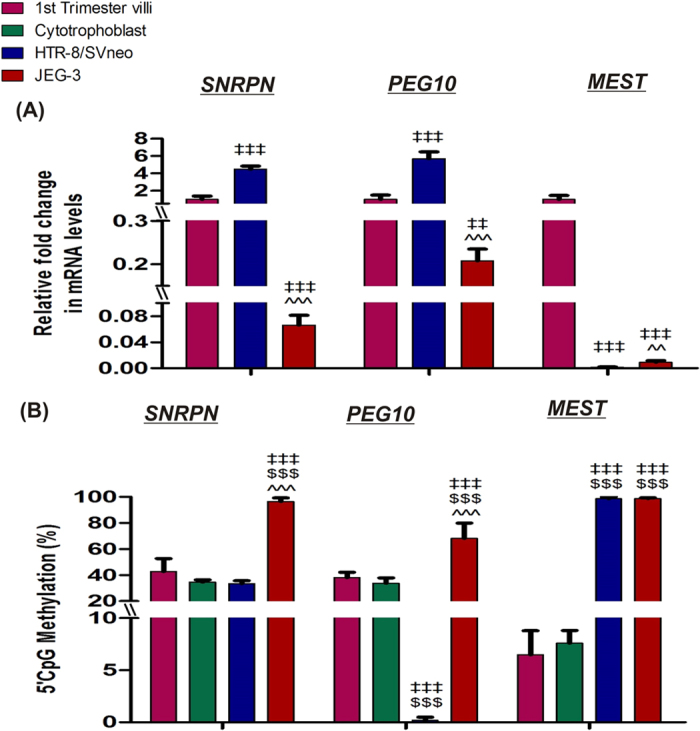
Regulation of differential mRNA expression via DNA methylation in placental cell lines, isolated cytotrophoblasts and normal first trimester placental villi.(A) qRT-PCR analysis of candidate tumor suppressor genes. (B) MS-HRM analysis of candidate tumor suppressor genes. ‡‡p < 0.01, ‡‡‡p < 0.001 vs first trimester villi, $$$p < 0.001 vs isolated cytotrophoblasts and ^^p < 0.01, ^^^p < 0.001 vs HTR-8/SVneo. The data is presented as mean of observed percentage methylation ± SEM of three experiments for cell lines, isolated cytotrophoblasts and for 30 patients in first trimester placental villi group.